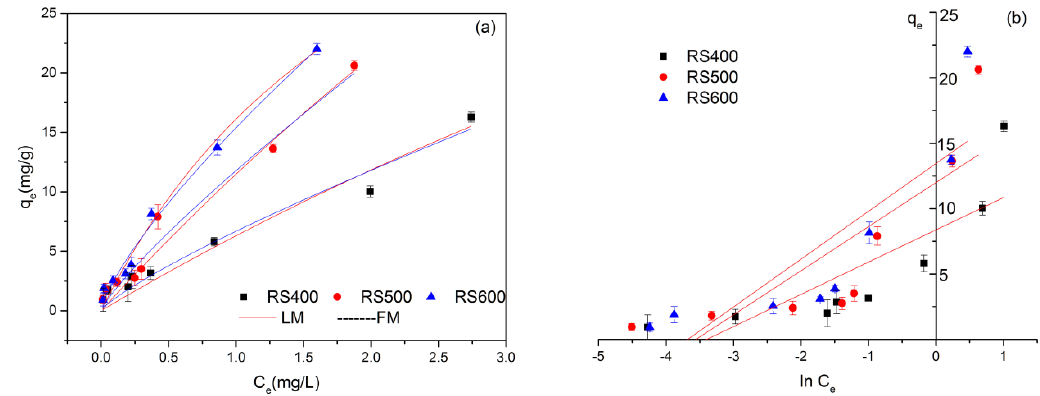
Figure 3. Adsorption isotherms of E2 of biochars produced at three temperatures. ( a ) Langmuir and Freundlich model; ( b ) Temkin model (initial E2 concentration = 0.2–6 mg L −1 ; sorbent dose = 0.01 g; contact time = 24 h).